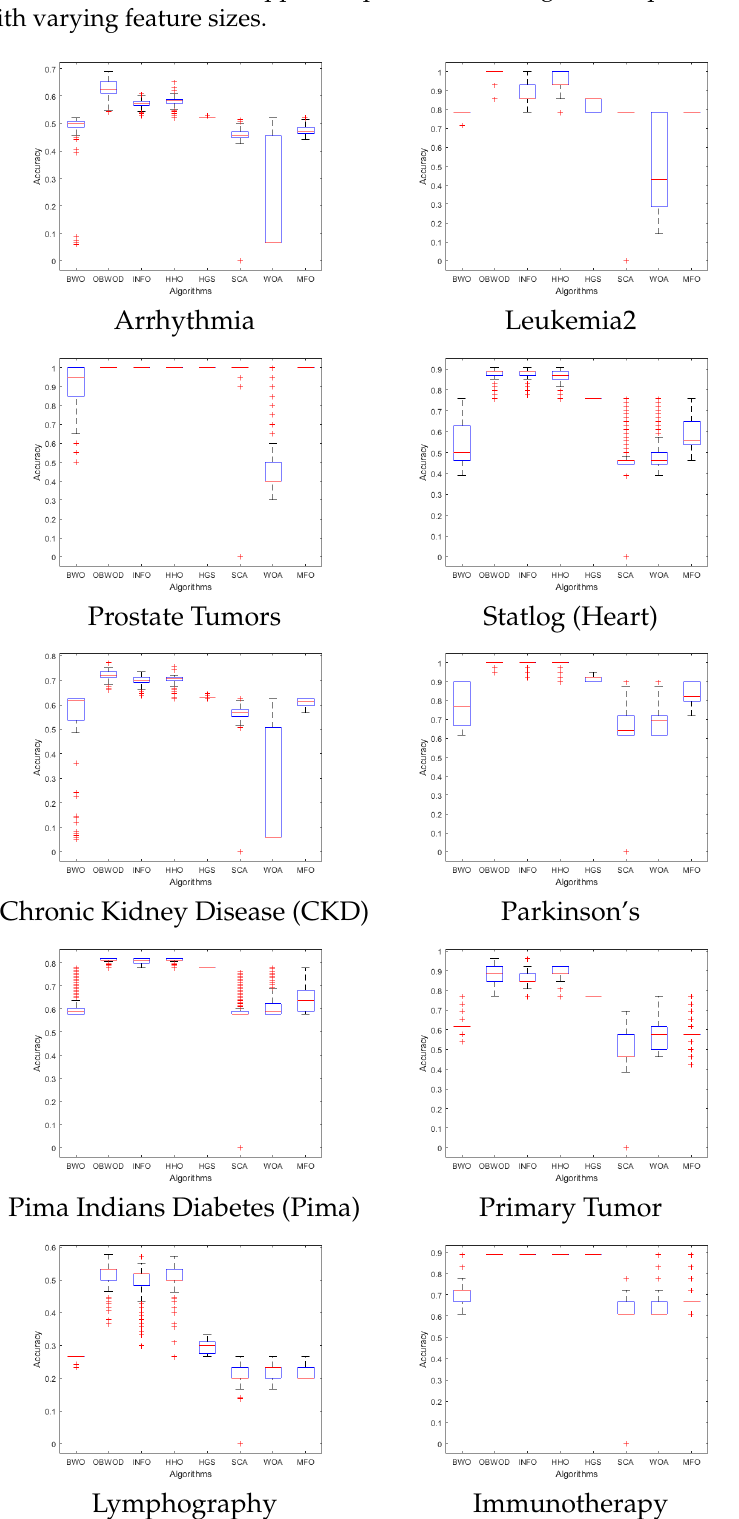
Figure 5. Boxplots of OBWOD and other optimization algorithms based on the kNN